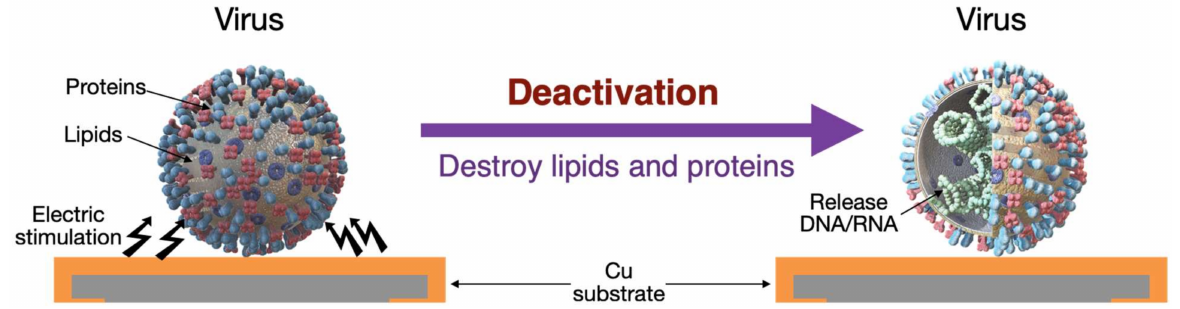
Figure 1. Schematic of a virus deactivated by a copper substrate through electrical